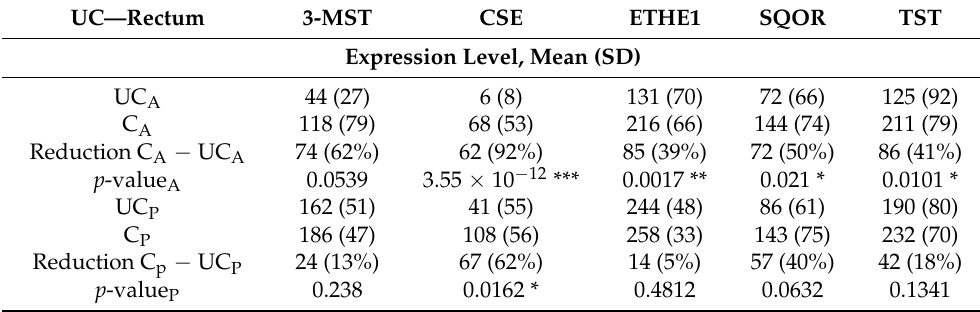
Table 6. Expression as mean with standard deviation (SD), absolute reduction and percentage as well as p -value of the rectum of ulcerative colitis (UC) separated by age group compared to age matched controls (C). Pediatric (P); adult (A); cystathionine- γ -lyase (CSE); 3-mercapto-sulfurtransferase (3- MST); ethylmalonic encephalopathy 1 protein (ETHE1); sulfide:quinone oxidoreductase (SQOR) and thiosulfate sulfurtransferase (TST). * = p -value < 0.05, **= p -value < 0.01, *** = p < 0.001.